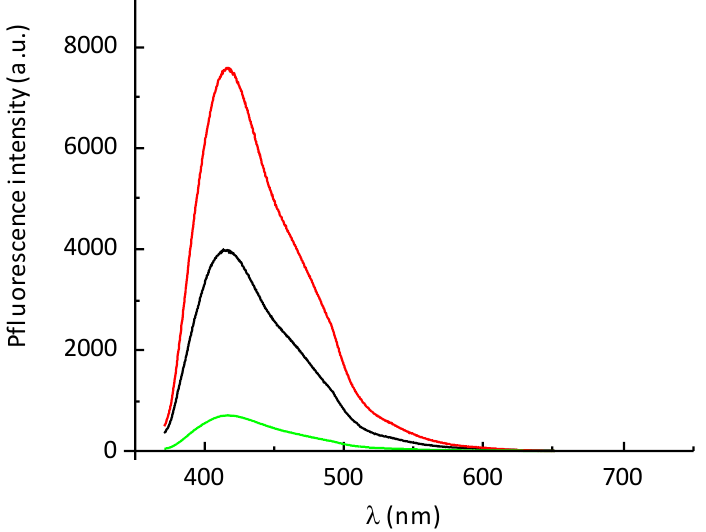
Figure 9. Fluorescence emission spectra of P797 at 5 × 10 − 6 mol.dm − 3 in acetonitrile + TBABF 4 0.1 mol.dm − 3 . [Imidazole] = 5 × 10 − 5 mol.dm − 3 . Black curve: before electrolysis (Species A in Scheme 2). Red curve after 1 Faraday/mole oxidation at 0.7 V/SCE (Species B in Scheme 2). Green curve: after addition of a tenfold excess of imidazole as a base on the previous (red curve) solution (Species C in Scheme 2). Excitation wavelength λ ex = 350 nm .